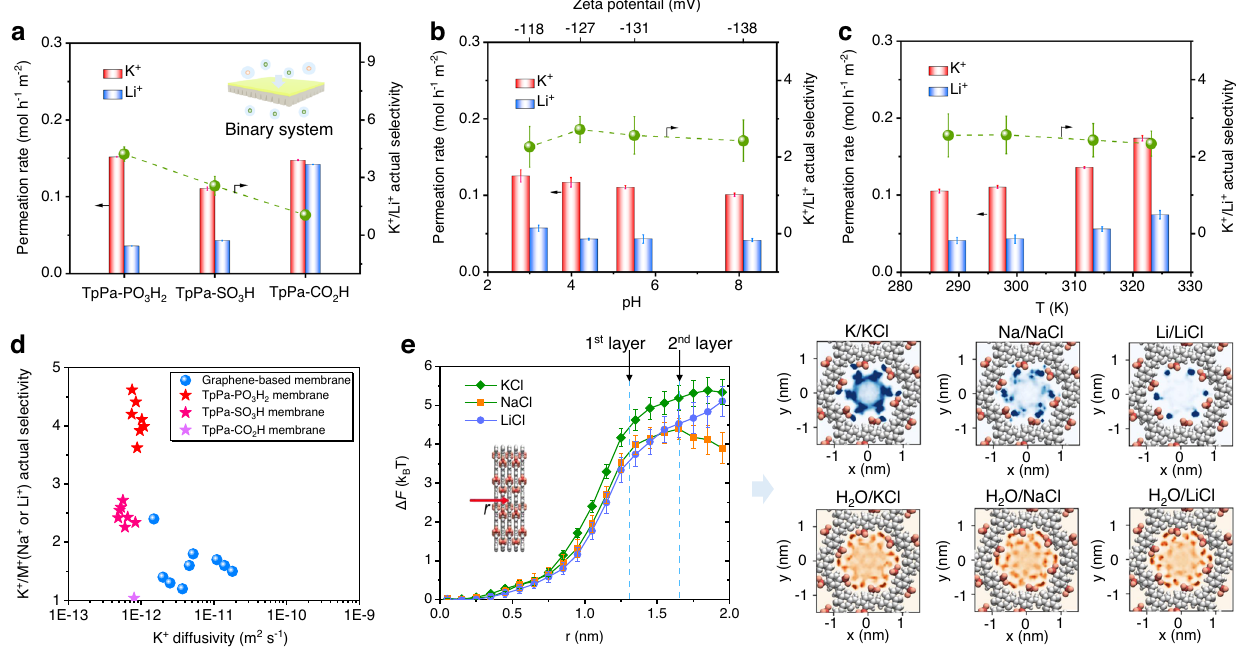
Fig. 6 | Separation performances for binary mixtures of monovalent cations through COF membranes. a Separation performances of TpPa – PO 3 H 2 , TpPa – SO 3 H, and TpPa – CO 2 H membranes for binary mixture of monovalent cations. b Separation performances of TpPa – SO 3 H membranes toward binary mixtures of monovalent cations under different pH. c Separation performances of TpPa – SO 3 H membranes toward binary mixtures of monovalent cations under dif- ferentoperationtemperatures. d ComparisonamongCOFmembranesinthisstudy